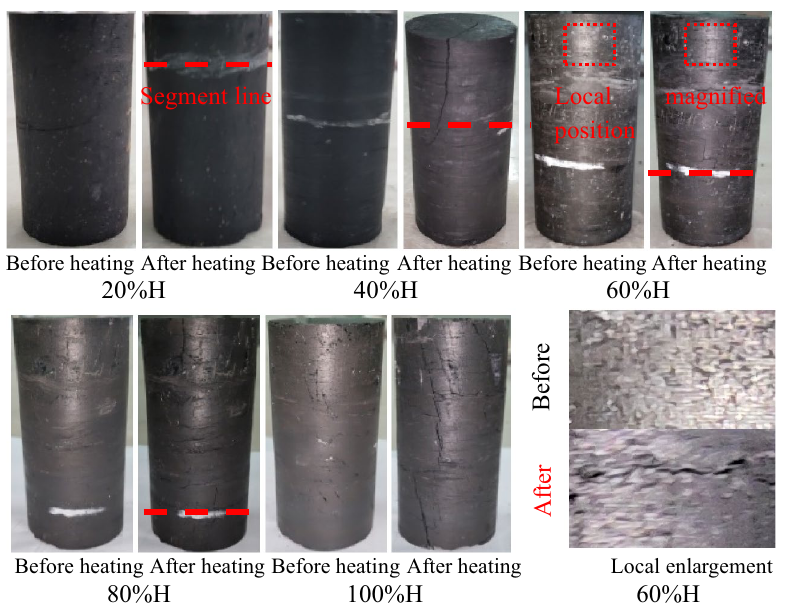
Figure 2. Comparison diagram of partially treated coal samples (Heating temperature is 300 °C) (Note: Before in the local enlargement means before heating; After means after